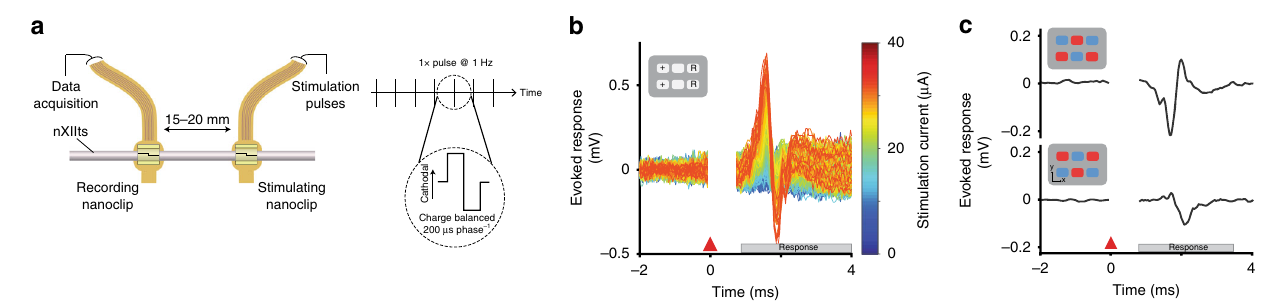
Fig. 6 Nanoclip-anchored thin- fi lm arrays enable low-threshold bulk and multichannel nerve stimulation. a Schema for acute stimulation of evoked compound action potentials. (Left) Current-controlled stimulation was delivered via a rostral nanoclip interface; evoked responses were recorded by a second nanoclip interface placed 15 – 20 mm caudally on the same nerve. (Right) Biphasic, cathodal-leading stimulating pulses, 200 μ s phase − 1 at 5 – 40 μ A, were delivered at 1 Hz. b Example of graded evoked response to increasing stimulation intensities. Stimulation applied at t = 0 ms; stimulation artifact appears t = 0 – 0.5 ms; evoked response follows. Inset shows stimulation electrode con fi guration —“ + ” denotes source of cathodal fi rst phase; “ R ” denotes electrodes for the current return path. c Evoked compound responses show that spatially distinct patterns of stimulation can produce a high degree of modulatory speci fi city. Inset shows the location of electrodes mediating stimulation pulses with cathodal (red) or anodal (blue) leading